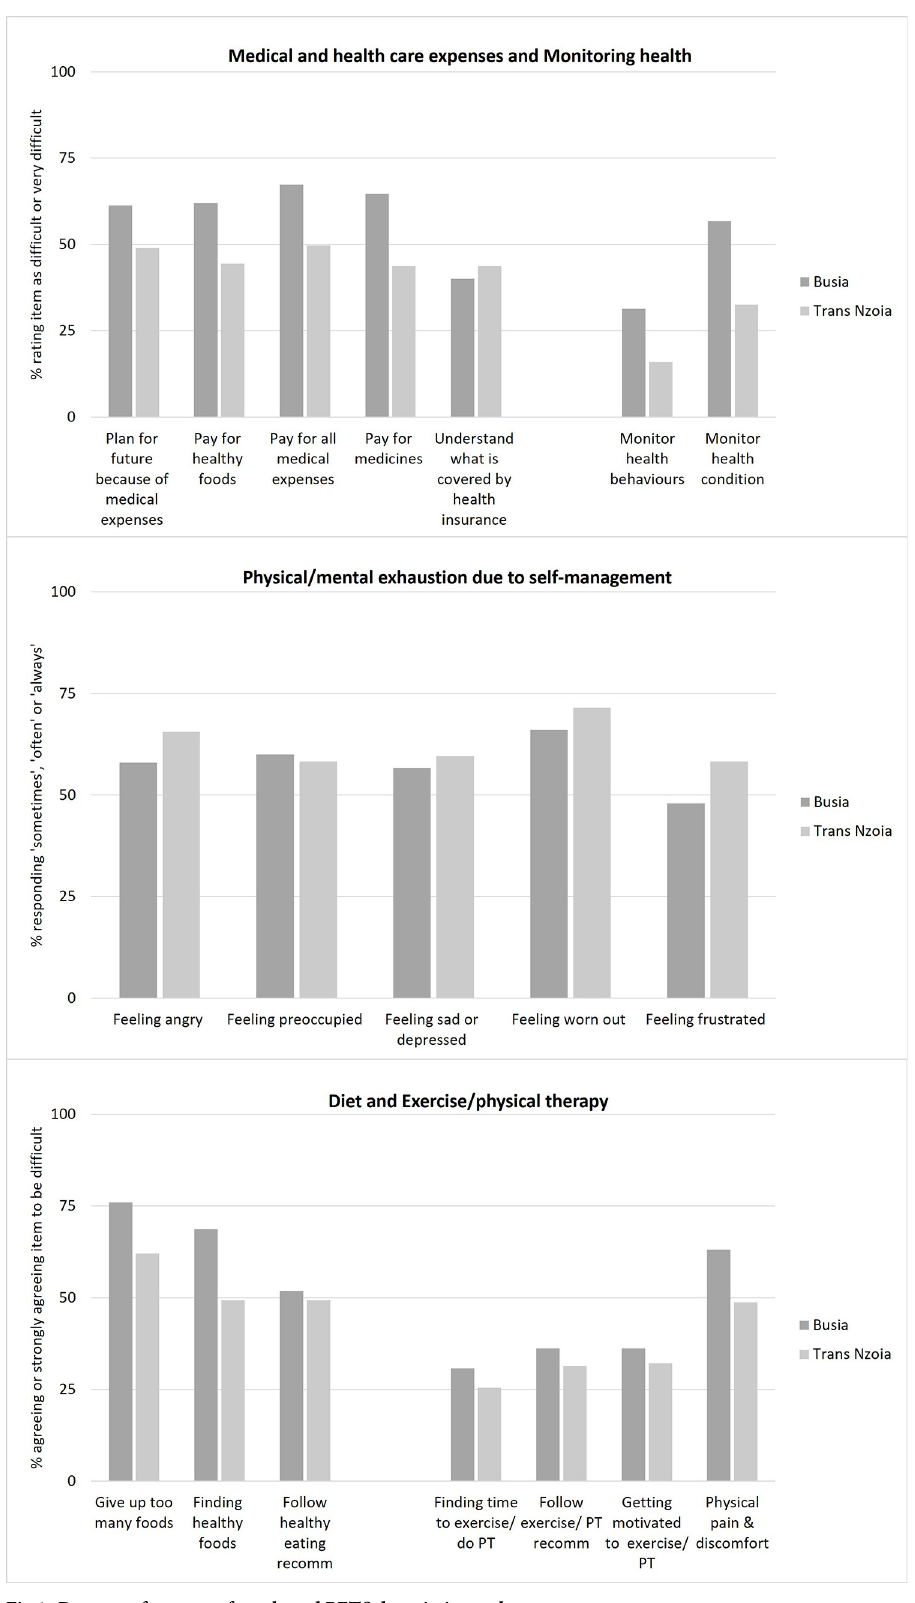
Fig 1. Response frequency for selected PETS domain items, by county. https://doi.org/10.1371/journal.pgph.0001407.g001 PLOS Global PublicHealth | https://doi.org/10.1371/journal.pgph.0001407 January17,